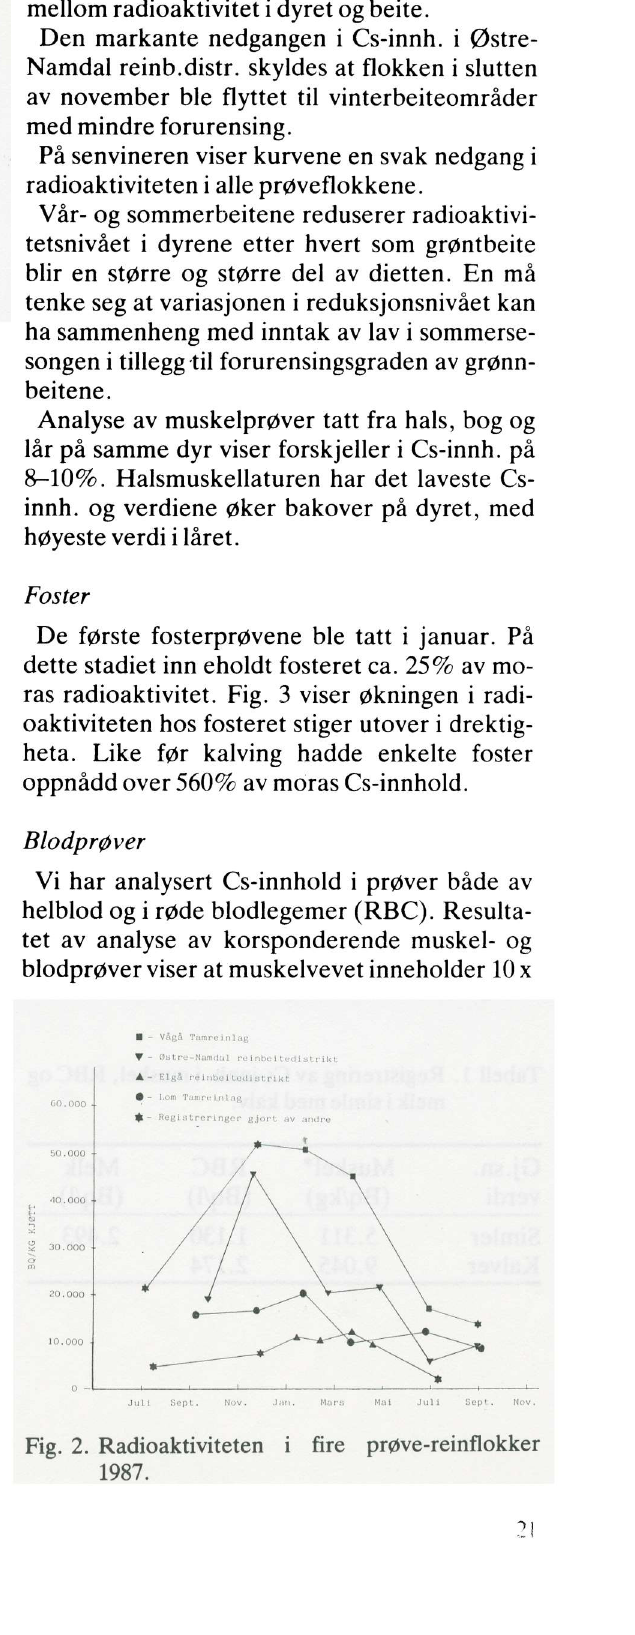
Fig. 2. Radioaktiviteten i fire prøve-reinflokker